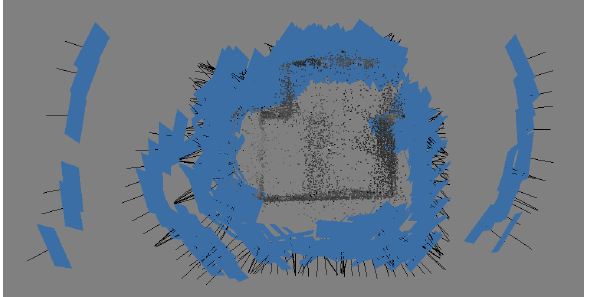
Figure 3. Visualisation of configuration of captured thermal images.